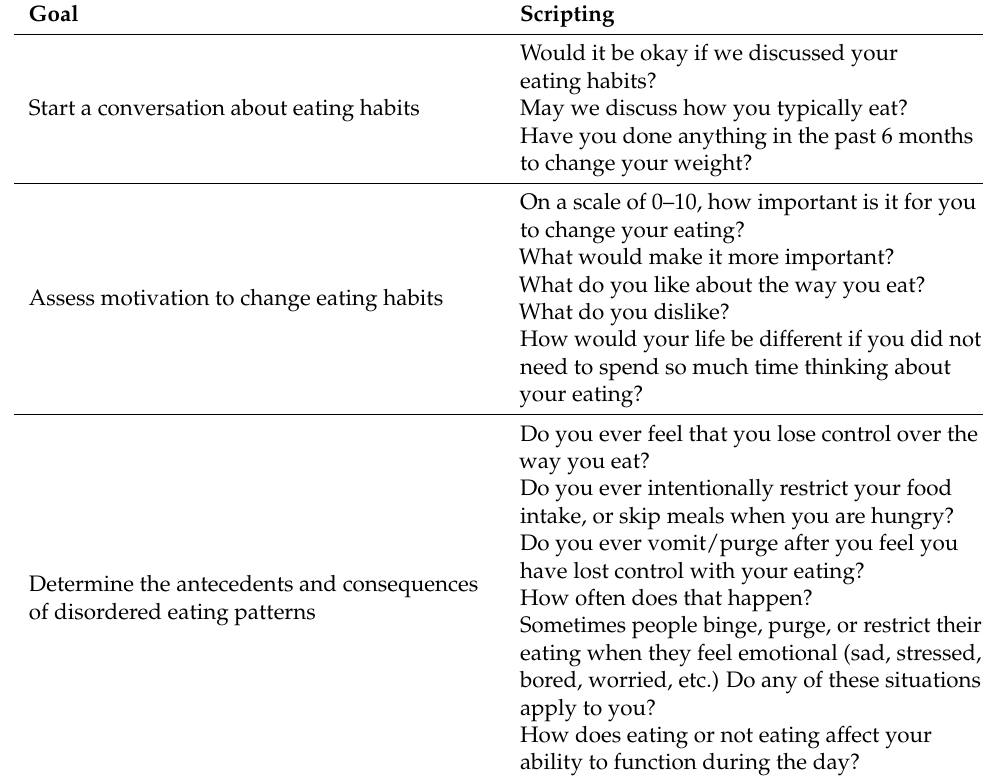
Table 2. Assessing Disordered Eating Behaviors in Adolescents [88]